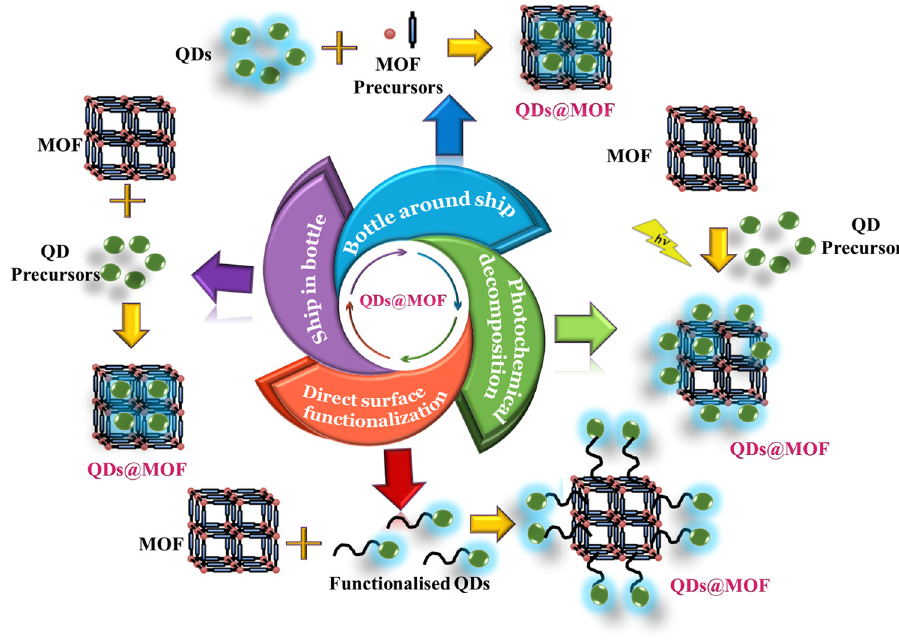
Figure 2: Schematic representation of various approaches deployed for the preparation of